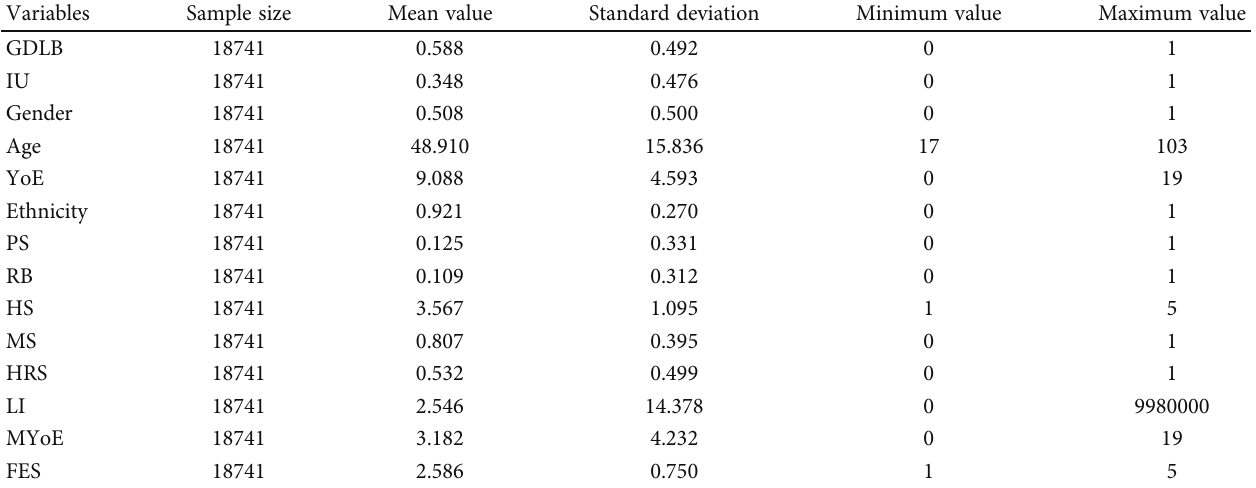
Table 1: Descriptive statistics of the